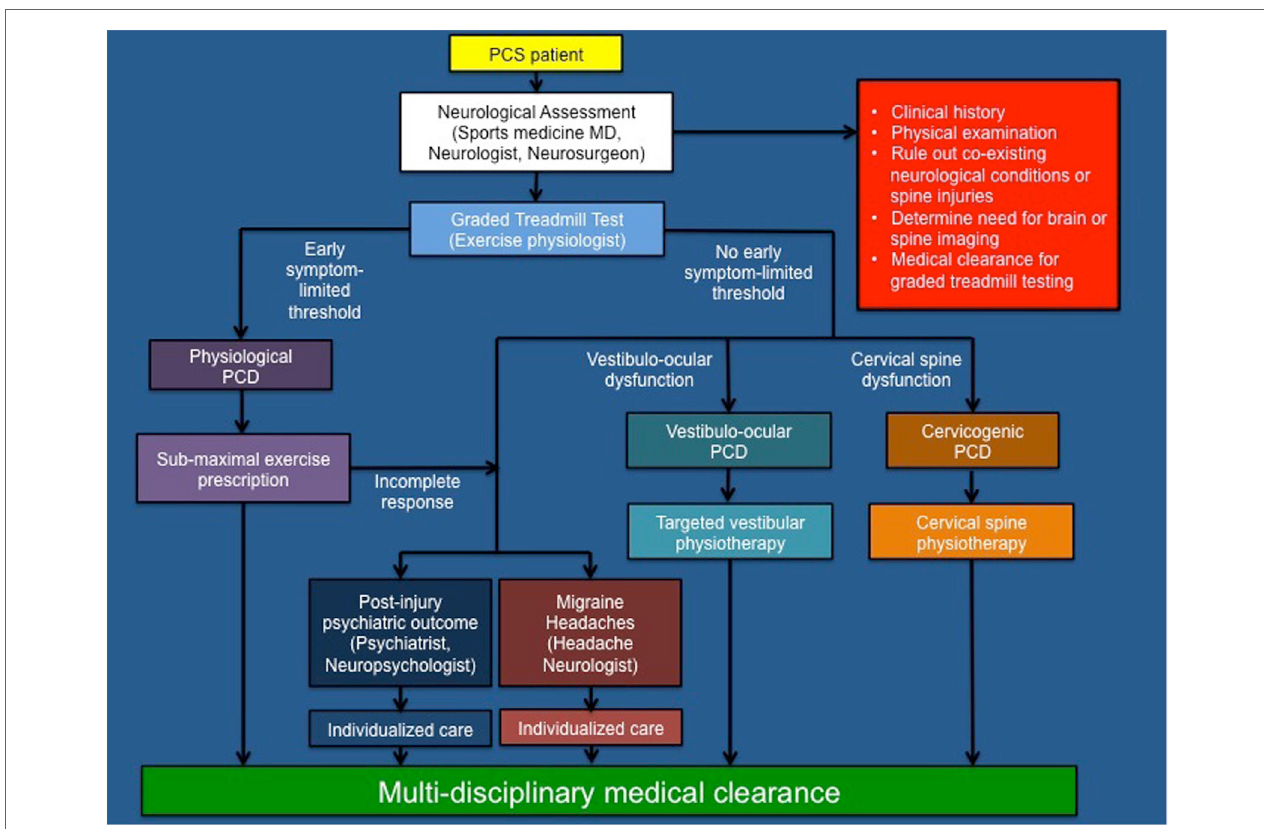
FiGUre 1 | summary of multi-disciplinary pathophysiological approach to athletes with post-concussion syndrome . PCS, post-concussion syndrome; PCD, post-concussion disorder; MD, medical doctor [modified with permission from original source (see footnote text 2), Journal of Neurosurgery Publishing